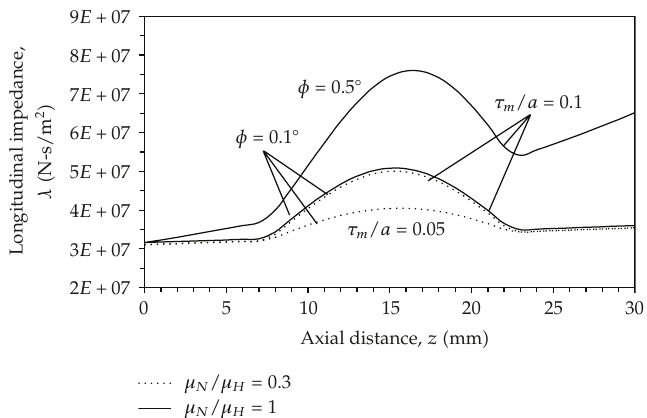
Figure 9: Variation of the longitudinal impedance to flow with axial distance at t (cid:7) 0.5 with α (cid:7) 0.95, τ y (cid:7) 0.1, and μ H (cid:7) 0.035.